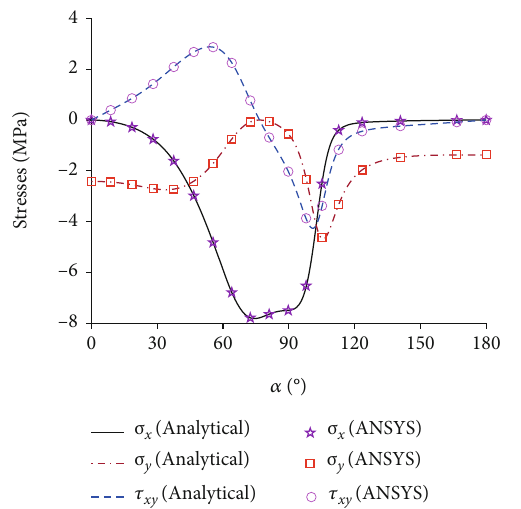
Figure 6: Comparison of stresses along the Oy -axis.